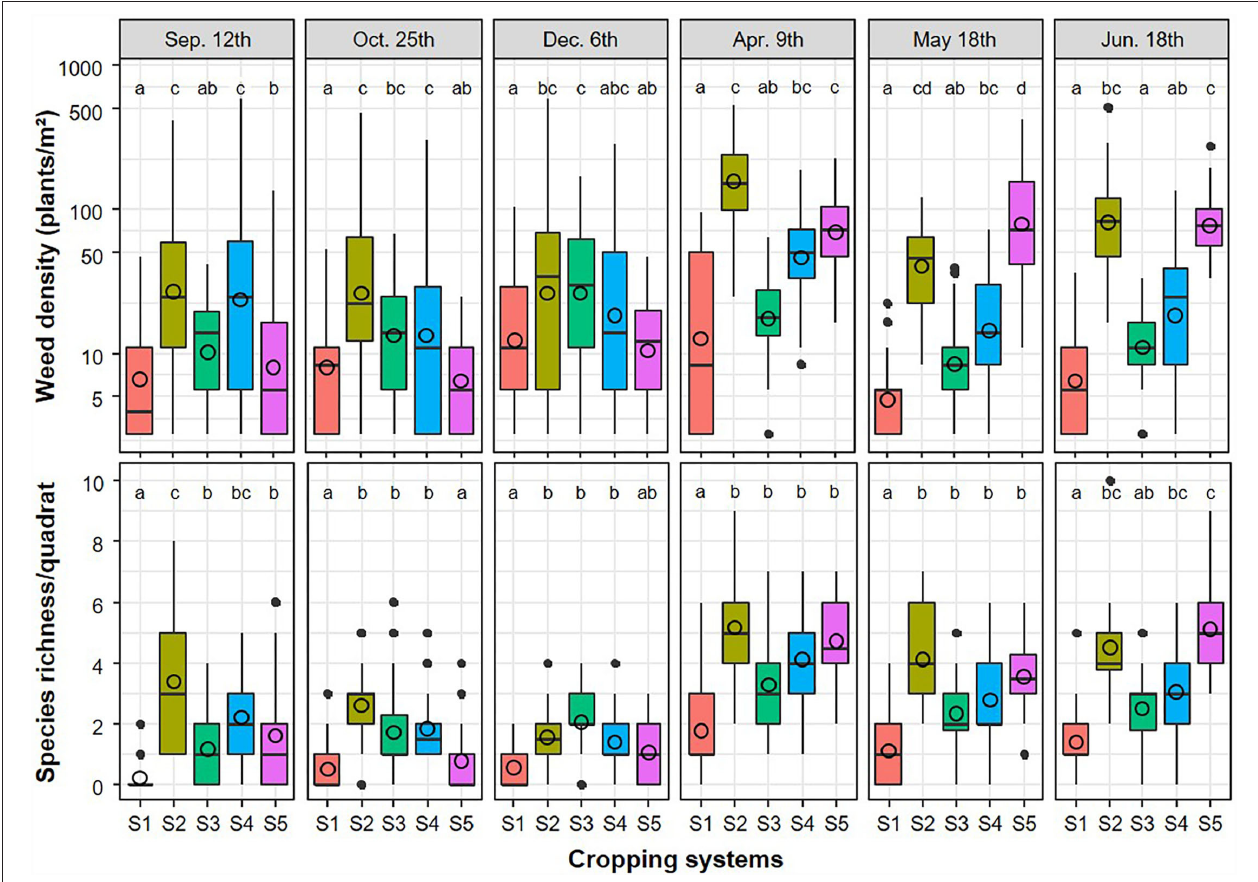
FIGURE 3 | Total weed density and species richness observed in the tilled strips (i.e., in situ superficial germinable seedbank) of the cropping systems (S1–S5) by sampling event (implemented approximately 6 weeks after each tillage event). Weed density model quality: R ² m = 0.51, R ² c = 0.59; Species richness model quality: R ² m = 0.60, R ² c = 0.65. Within a sampling event, mean values (open circles) for each systems are not different at P < 0.05 if they share the same